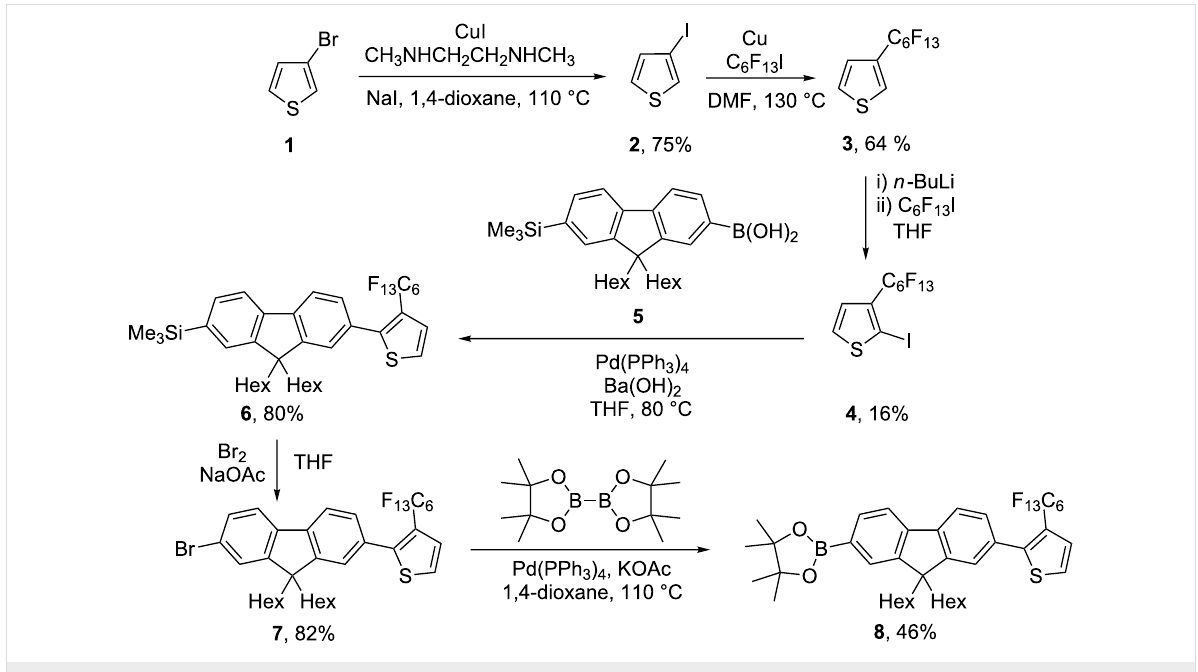
Scheme 1: Synthesis of the thiophene-fluorene arm for the 3-isomer.